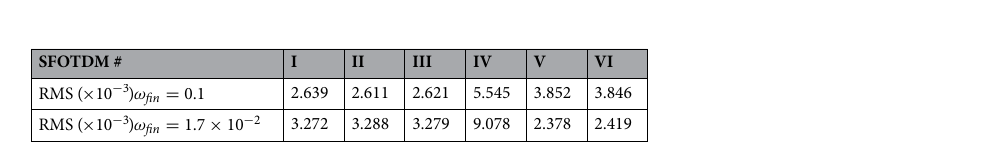
Table 3. SFOTDM Nyquist plot RMS